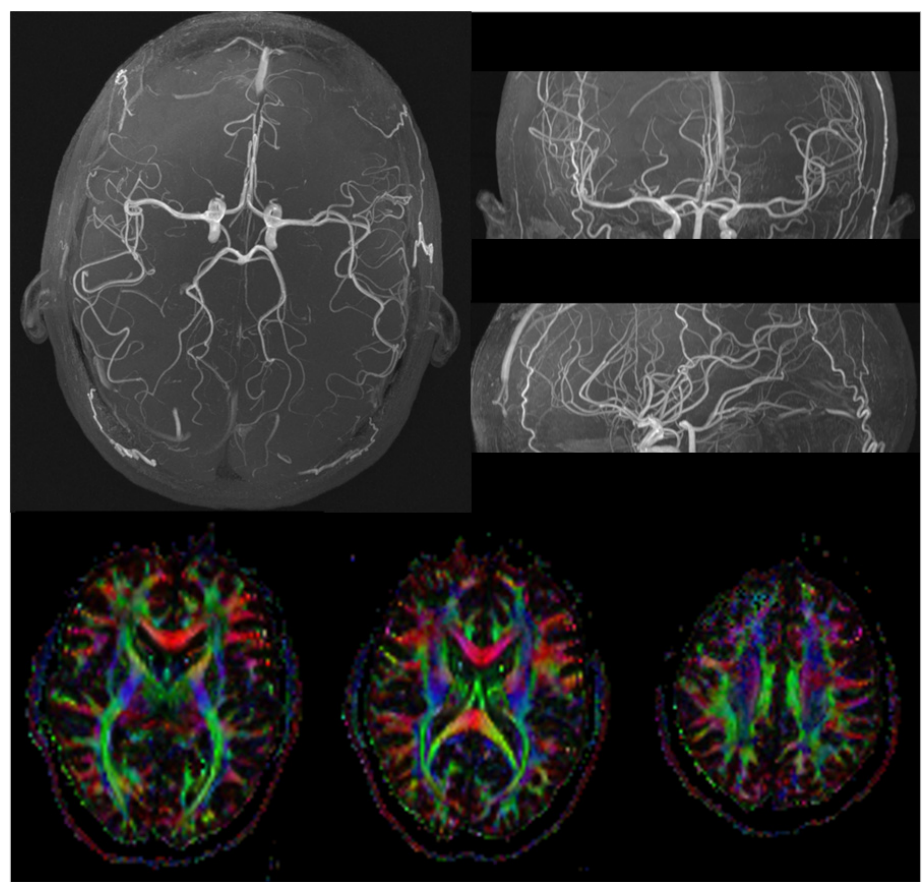
Figure 8. ( Top ) Images of magnetic resonance angiography (MRA). ( Bottom ) Diffusion tensor imaging (DTI) with colors indicating directions as follows: red, left–right; green, anteroposterior; blue, superior–inferior.